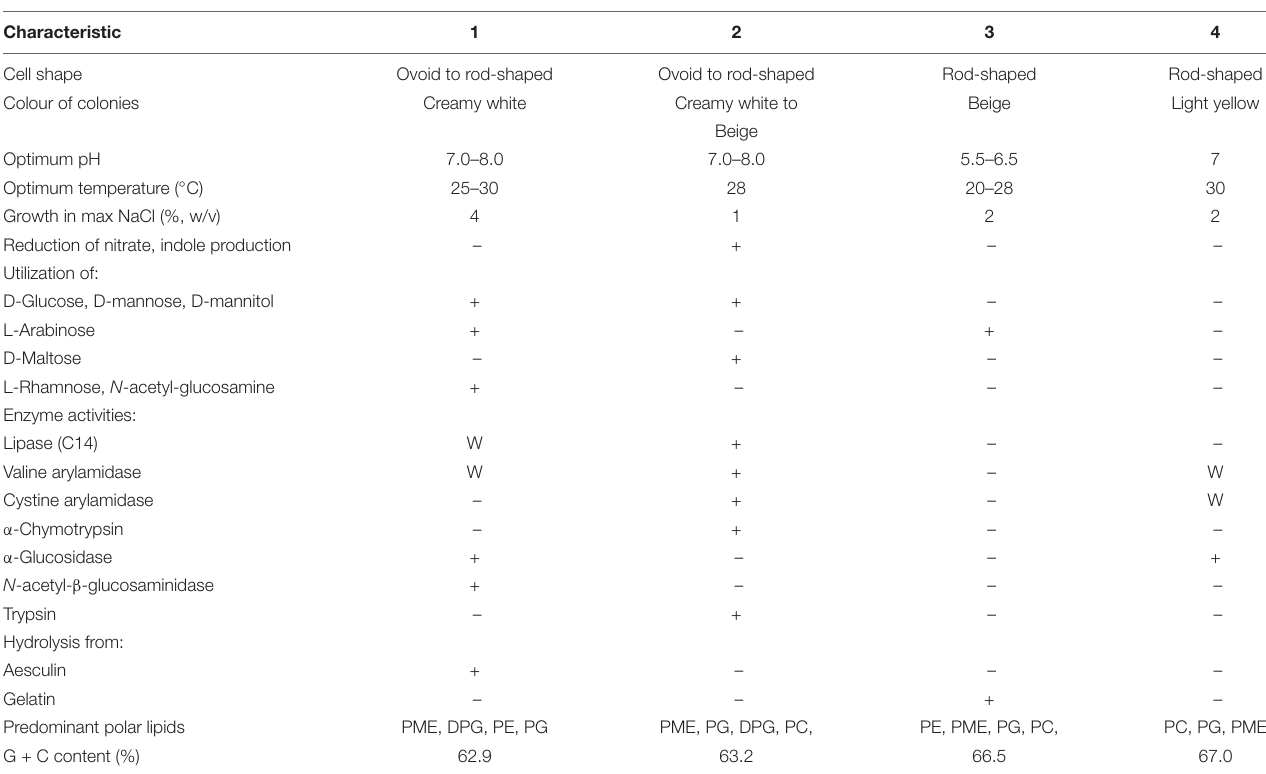
TABLE 2 | Differential characteristics of strain D13-10-4-6 T and closely related reference strains.